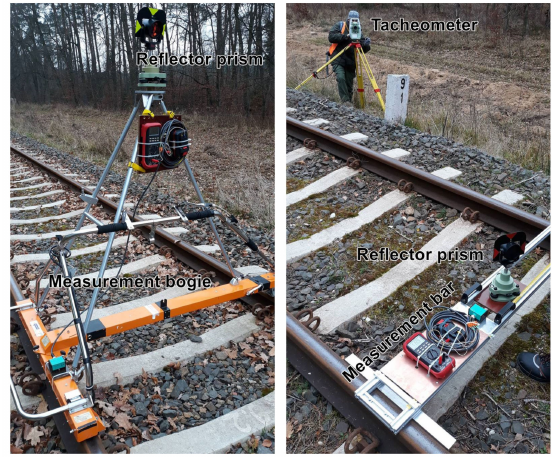
Figure 7. Measuring units used in static measurements.